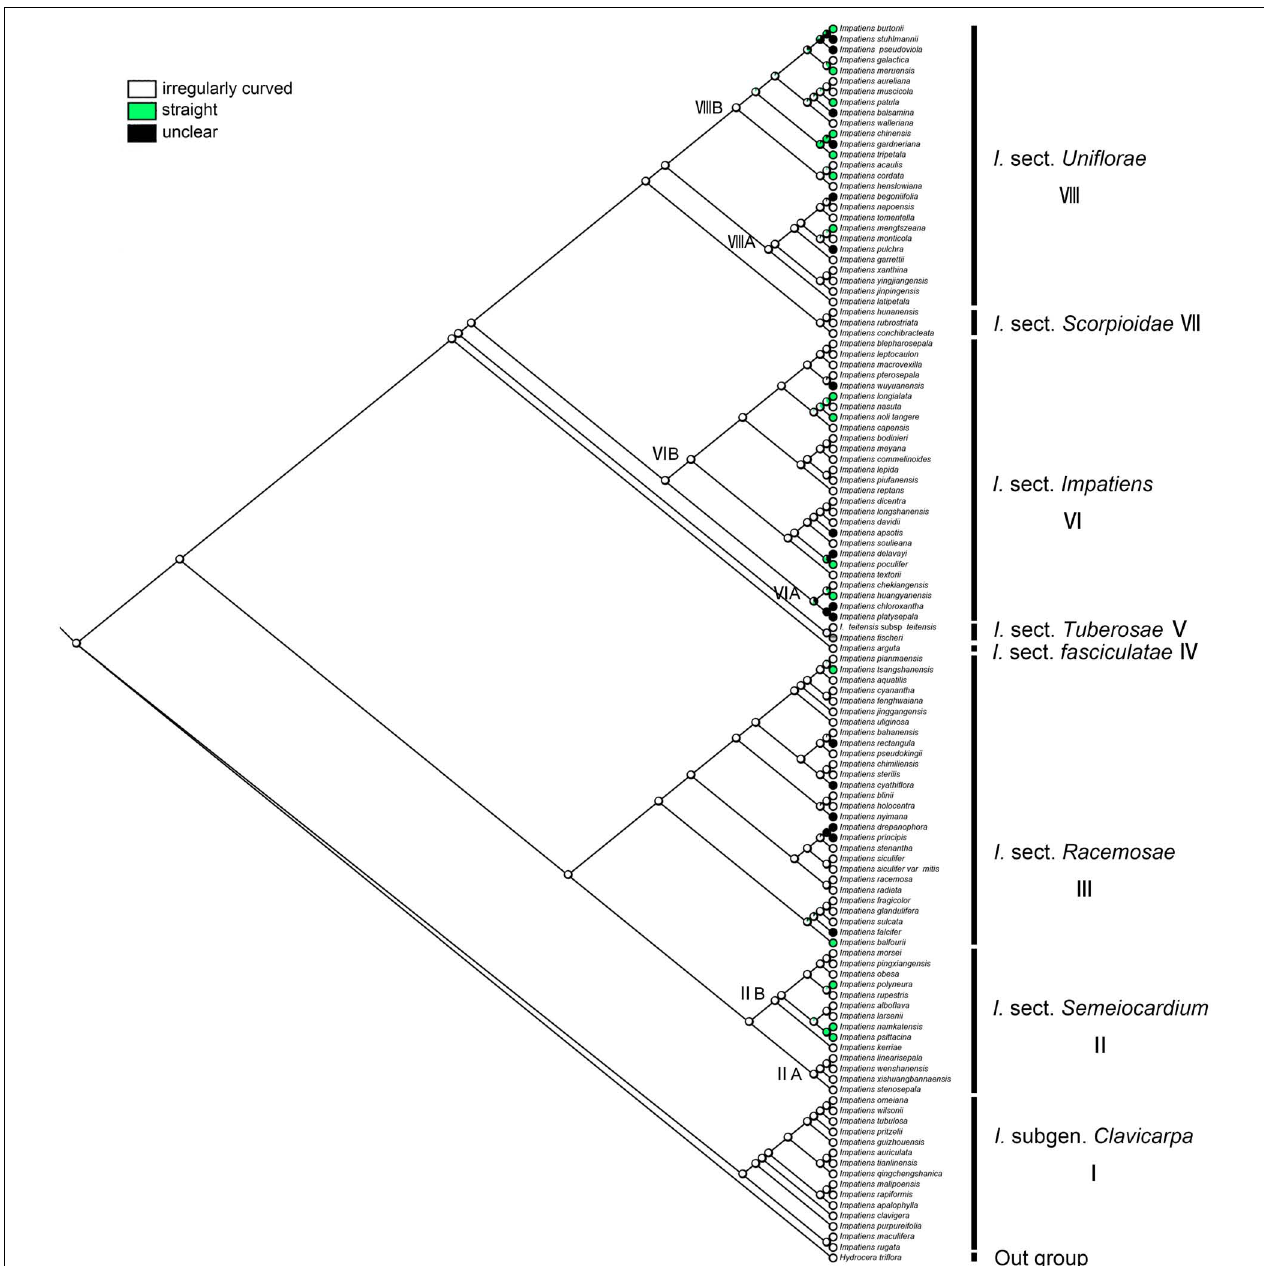
FIGURE 11 | Ancestral reconstruction of the anticlinal cell wall in Impatiens using ML. Three characteristic states of anticlinal cell wall of Impatiens optimized on the BI tree by using different colors.